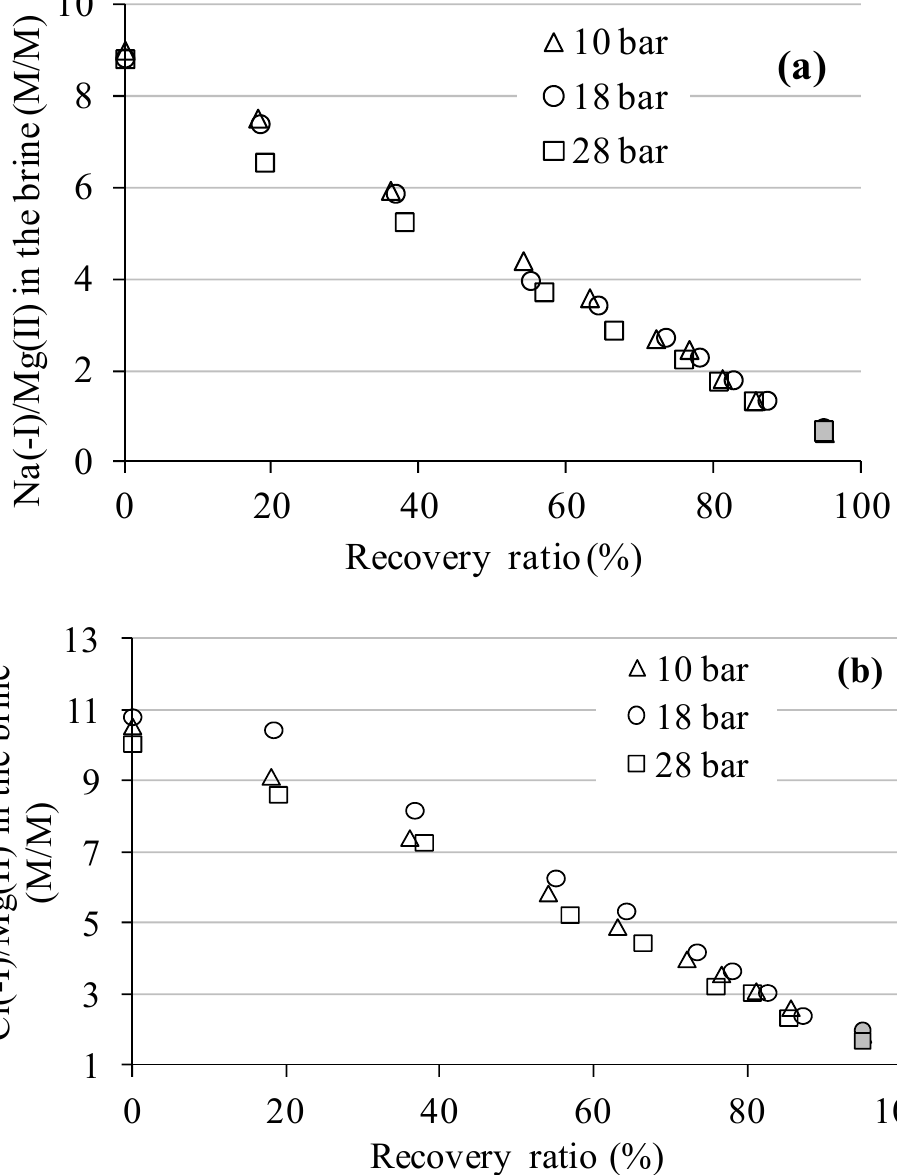
Figure 3. Molar concentration ratios of Na(I) to Mg(II) ( a ) and Cl( − I) to Mg(II) ( b ) in brines generated at 10, 18 and 28 bar ( ∆ , ○ and □ , respectively), as a function of the recovery ratio. The 95% recovery ratio points (filled bars) are estimations based on linear extrapolation, while all other points are the measured